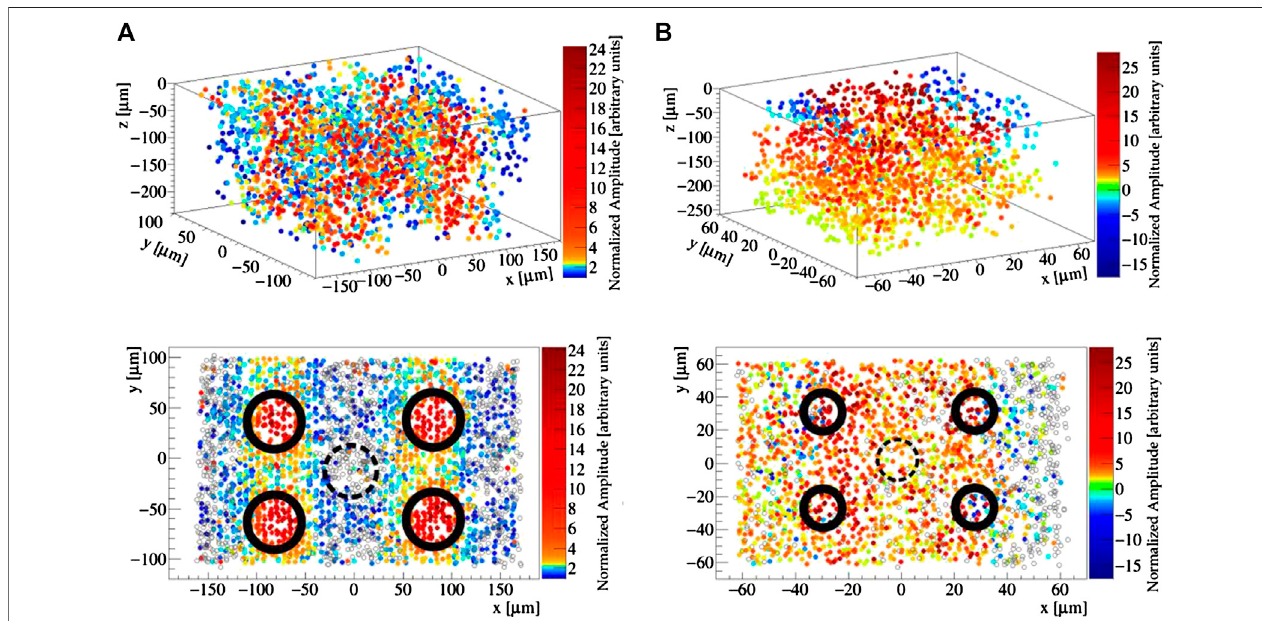
FIGURE 8 | Graphical representation of the dependence of the signal amplitude on the point of excitation of Sensor A (A) and Sensor B (B) with Ti:Sapphire laser pulses. The three-dimensional scans depicted on the top, are projected onto the transverse plane xy in the bottom row. Empty markers indicate measurements where the signal cannot be distinguished from noise. Thick black solid circles indicate the position of the polarisation electrodes, the central dashed circles correspond instead to the readout